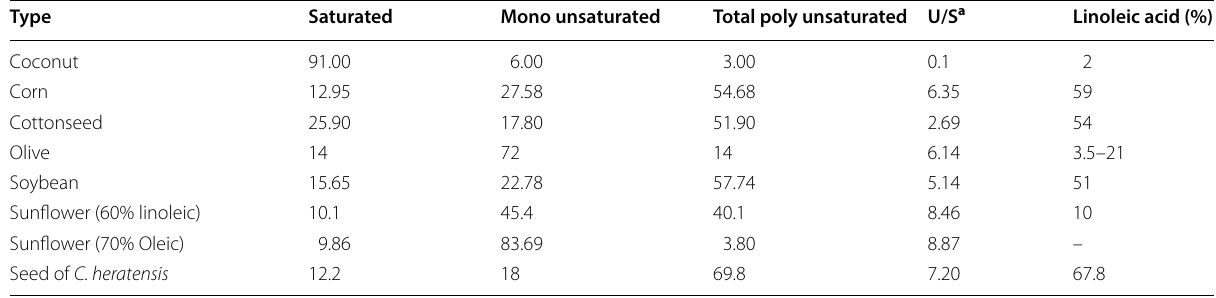
Table 2 Comparison of fatty acids composition of C. heratensis seed with the various vegetable oils (Katragadda et al.